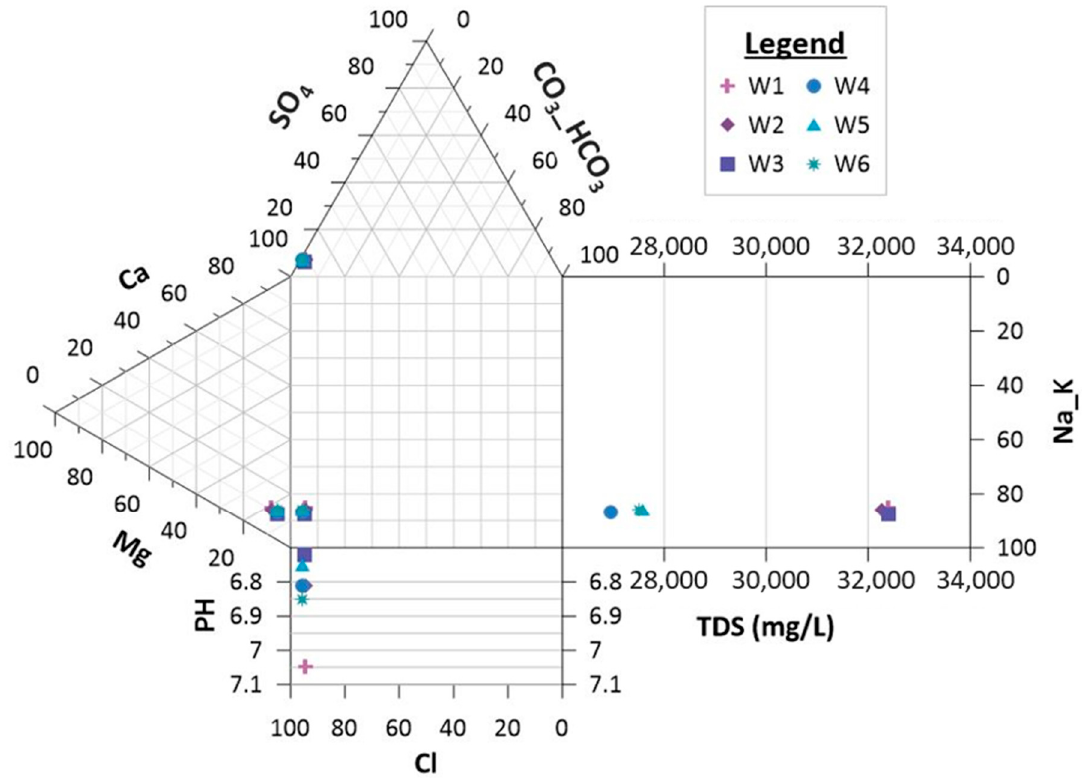
Figure 14. Durov plot for groundwater samples of unconfined and leaky aquifers. Generally, the cation and anion concentration values of the groundwater in layer A were higher than in layer B. In layer A, the cation concentrations were in the order of Na + > Ca 2+ > K + > Mg 2+ except for one sample, while in layer B, the cation concentrations were in the order of Na + > Ca 2+ > Mg 2+ > K + (Figure 14). The sodium concentration was the most dominant and ranged from 9100 mg/L to 9550 mg/L in layer A and from 7850 mg/L to 7950 mg/L in layer B. The calcium concentrations had the second-highest values and were in the ranges of 555–658 mg/L and 525–569 mg/L in layers A and B, respectively. The con- centrations of magnesium and potassium had averages of 234 mg/L, and 266 mg/L in layer A and 215 mg/L and 175 mg/L in layer B. The cation concentration values (Ca 2+ , Mg 2+ , Na + , and K + ) of the groundwater were higher than the WHO limits.